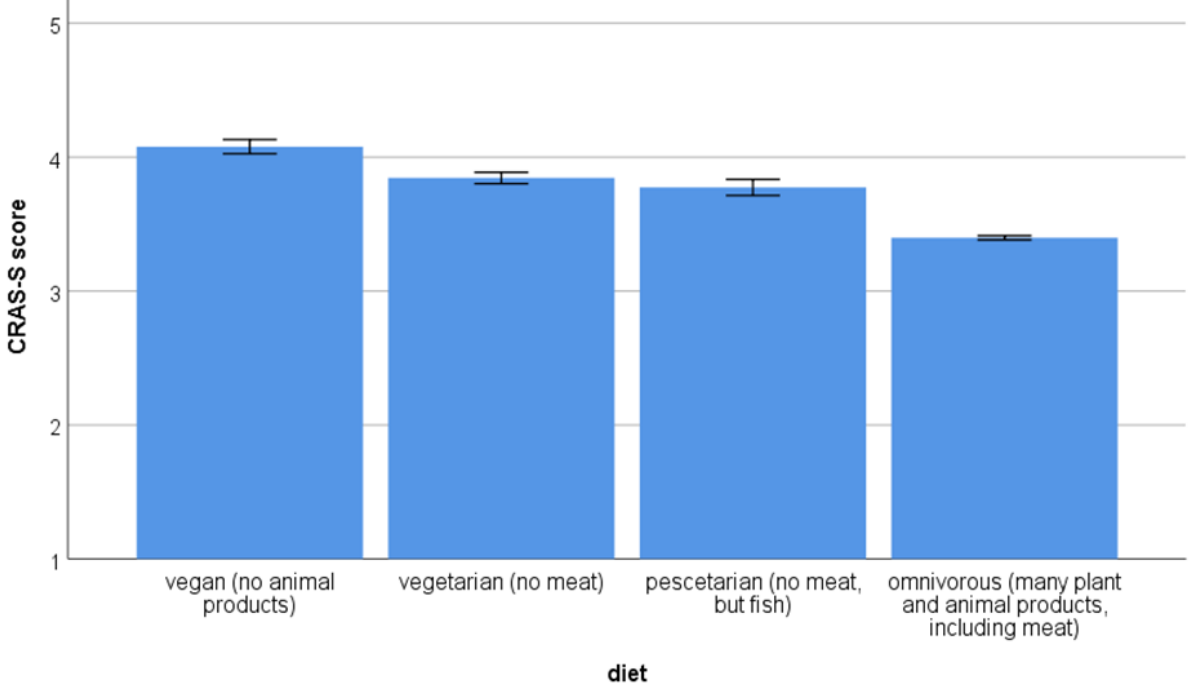
Figure 2. Animal welfare attitudes according to diet. Higher scores represent higher pro-animal welfare attitudes. Animal welfare attitudes (AWA) were measured with the Composite Respect for Animals Scale-Short Version (CRAS-S).